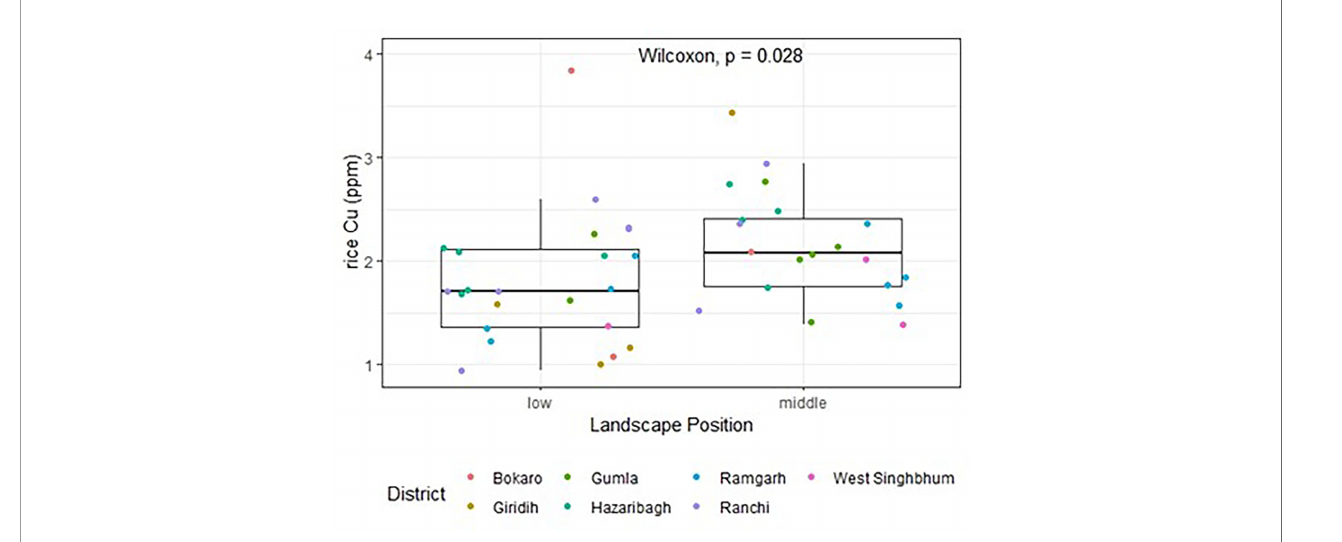
FIGURE 7 | Rice Cu concentrations by landscape